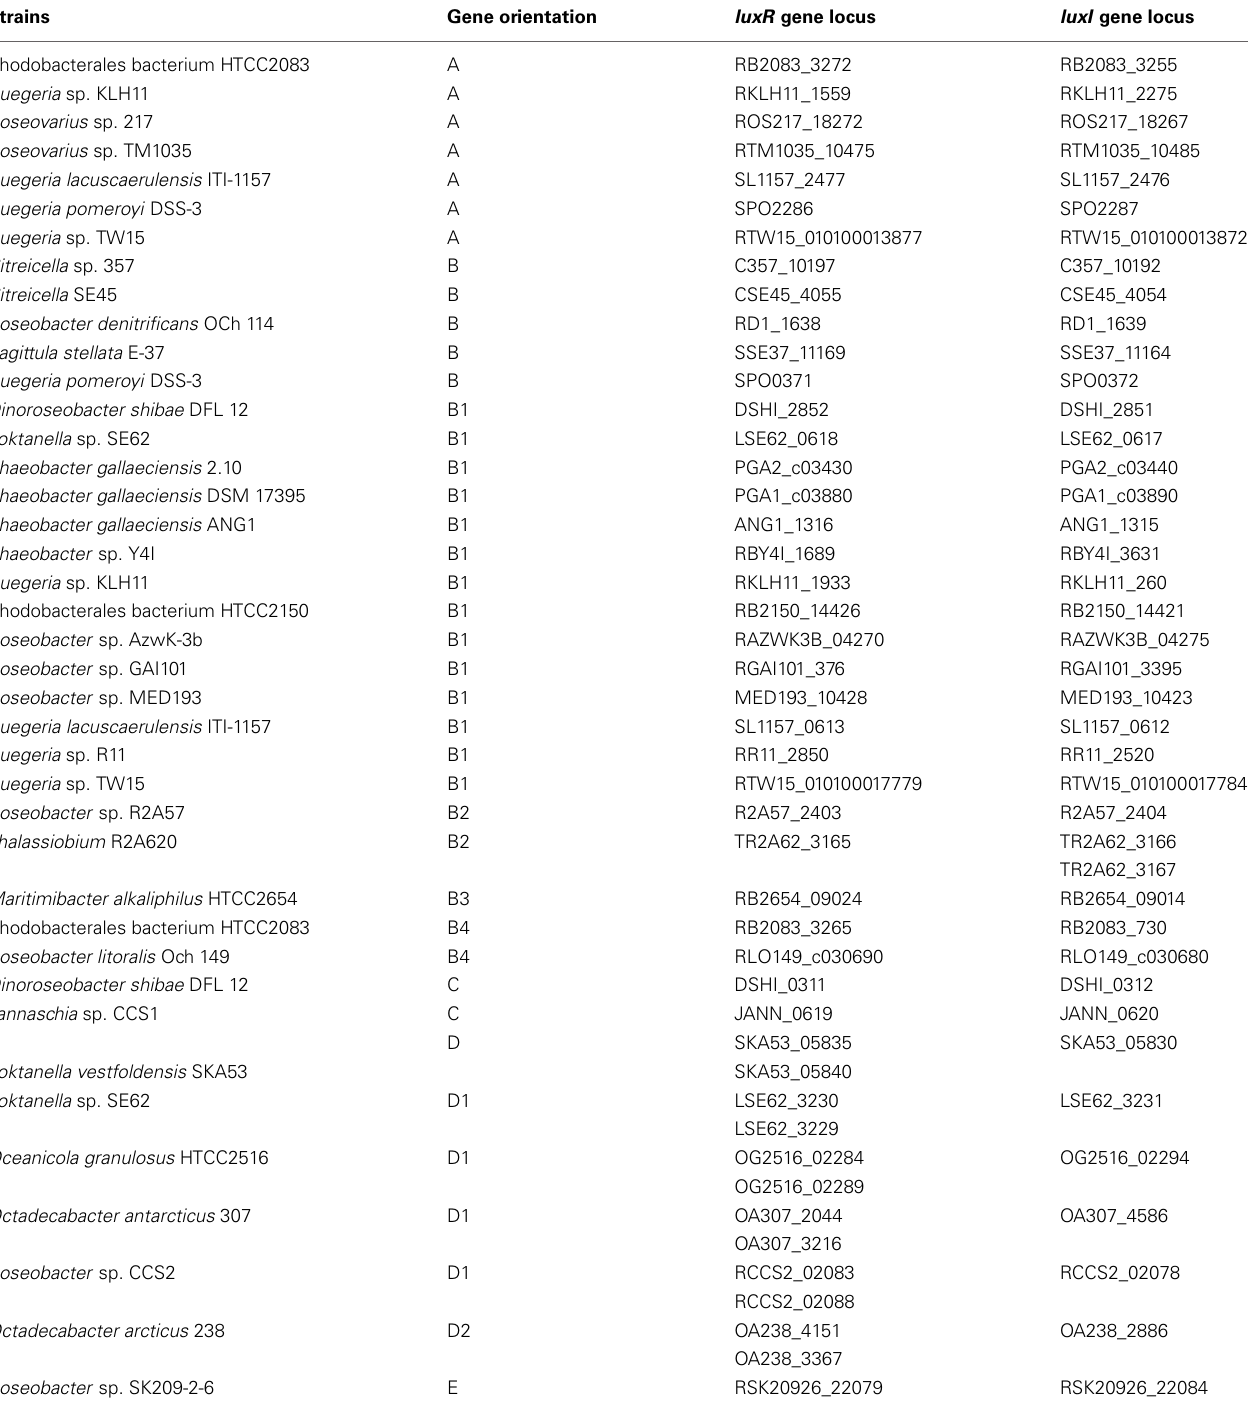
Table A1 | Paired LuxRI and orphan LuxI a homologs identified in the 38 sequenced roseobacters. Strains Gene orientation luxR gene locus luxI gene